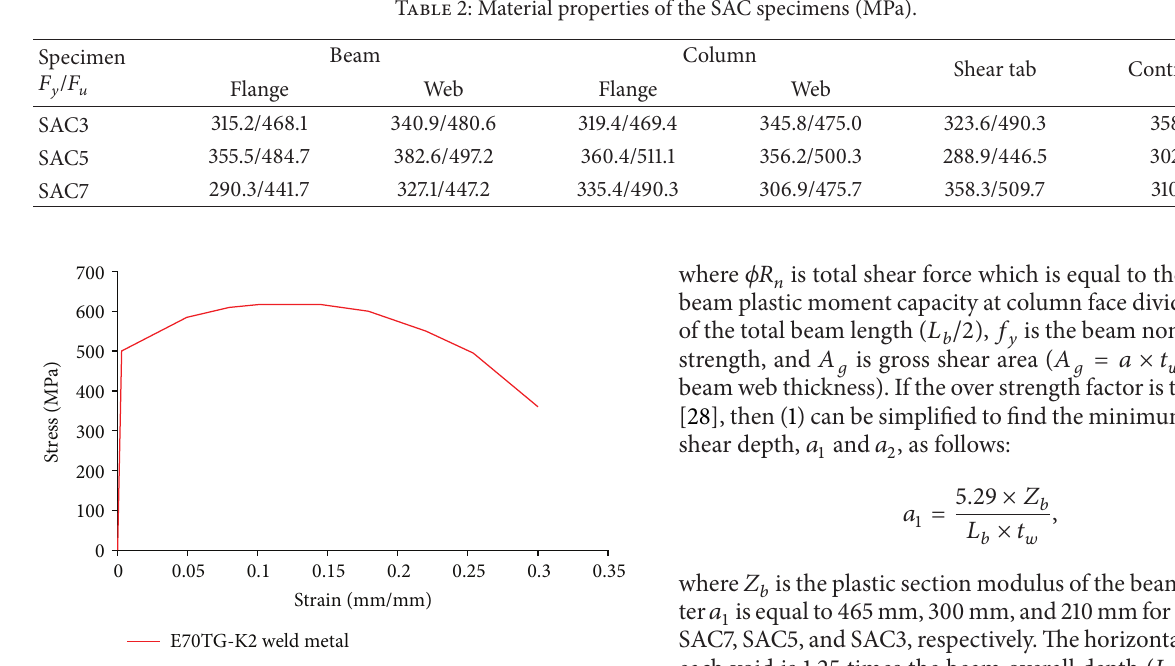
Figure 5: Stress-strain relationship used for the weld metal (Mao et al. [24] and Ricles et al.